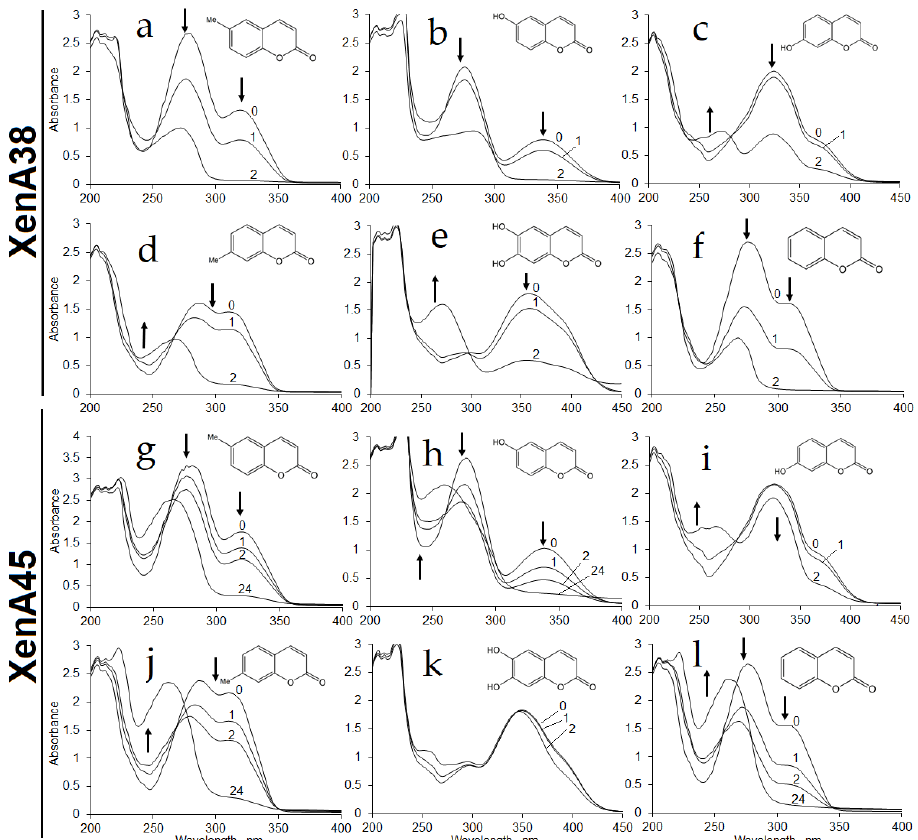
Figure 2. Biotransformation of 6-methylcoumarin ( a , g ), 6-hydroxycoumarin ( b , h ), 7-hydroxycoumarin ( c , i ), 7-methylcoumarin ( d , j ), 6,7-dihydroxycoumarin ( e , k ) and coumarin ( f , l ) by whole cells of E. coli BL21 containing xenA38 ( a – f ) or xenA45 ( g – l ) gene. Biotransformation was carried out in 50 mM potassium phosphate buffer pH 7.2 at 30 °C with 0.5 mM of substrate. Incubation time (hours) is shown above the curves. In several experiments ( c , e , i , k ), the spectra after an incubation for 24 h were omitted, due to a massive lysis of cells taking place during a prolonged incubation. Arrows indicate changes in absorbance.